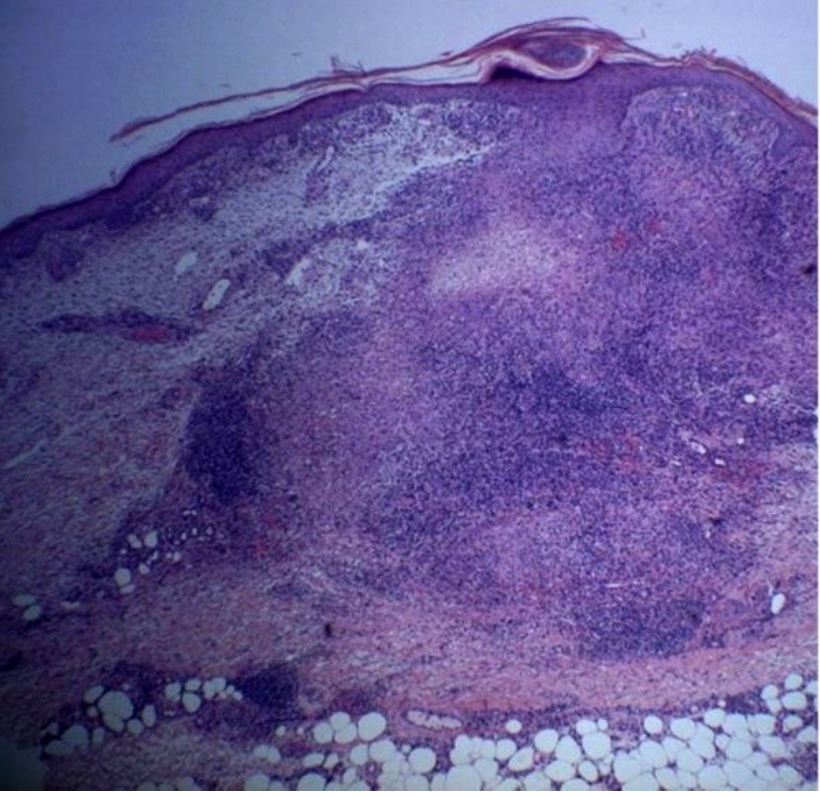
Figure 2. Inflammatory infiltrate composed by lymphocytes and histiocytes occupying the papilar and reticular dermis with palisading granulomas surrounding necrobiotic collagen (H&E 40×).